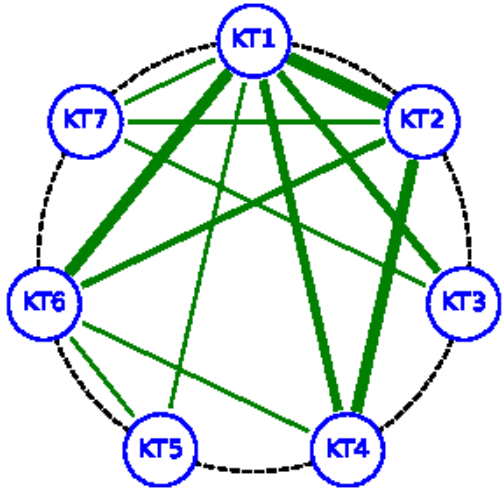
Figure 3. The original graph G of key terms.